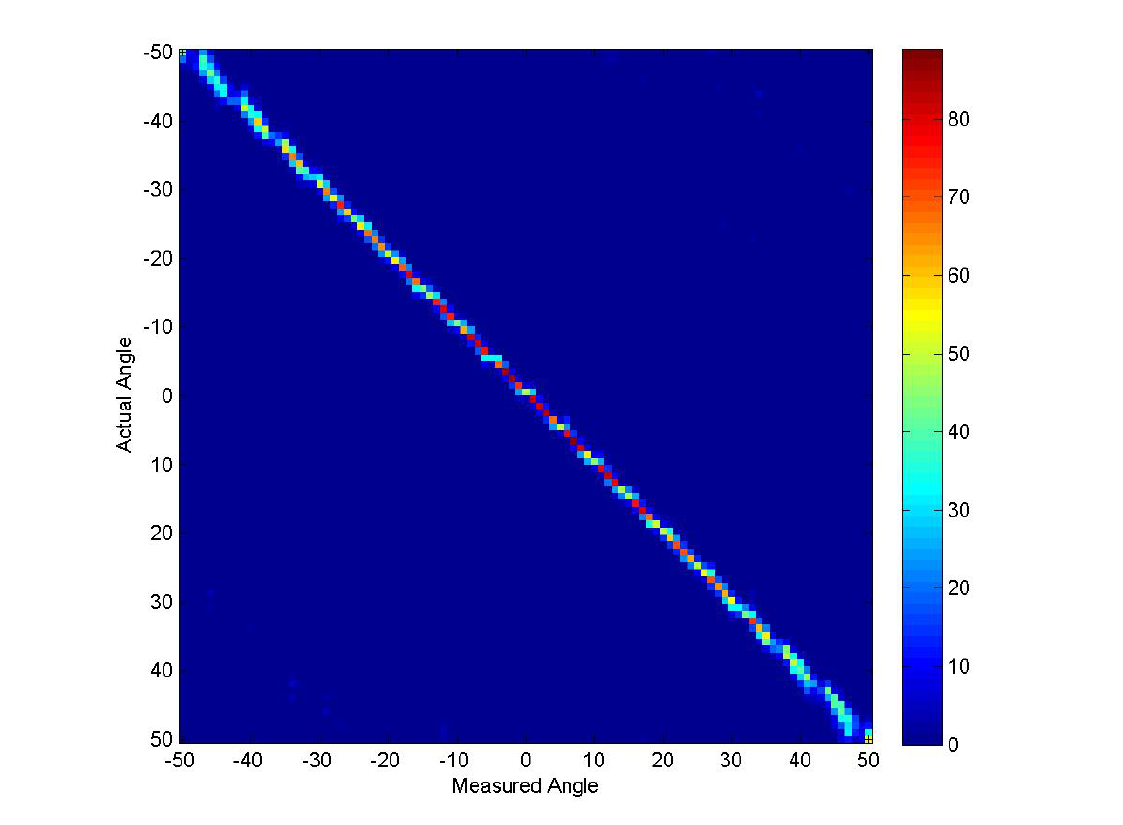
Figure 8. Ambiguity plot for Experiment 2 (no